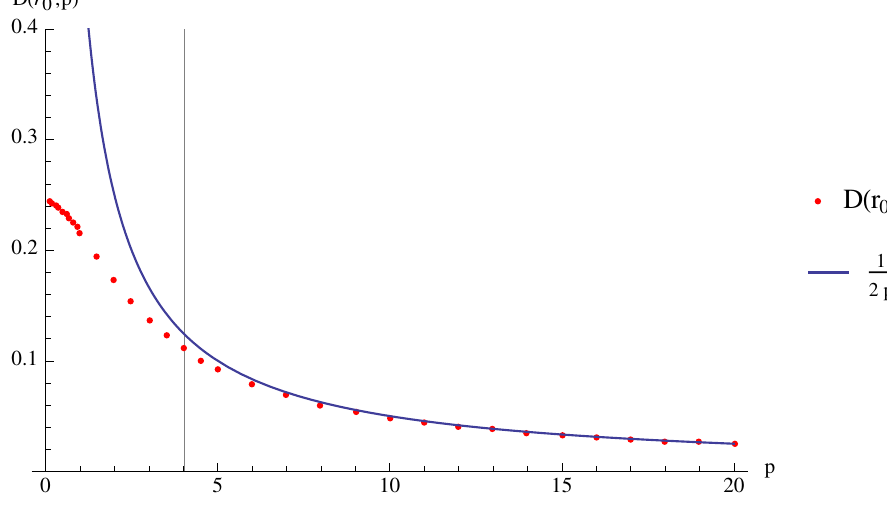
Figure 7 . The function D ( r 0 ; p ) as a function of momentum, compared with 1 = 2 p . This graph is obtained numerically from the speci(cid:12)c example with AdS UV and IR asymptotics presented in section 2.6.1. The scales on both the horizontal and the vertical axis are in units of the UV AdS length. The transition scale 1 =r t (solid line) is about 4 (in UV-AdS